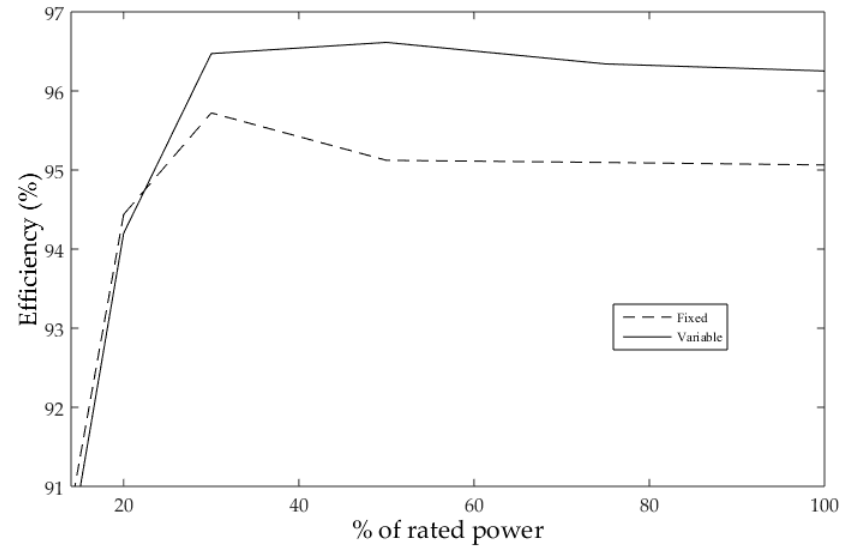
Figure 14. Measured efficiency curves. Table 3. Inverter performance f sw = 25 KHz.